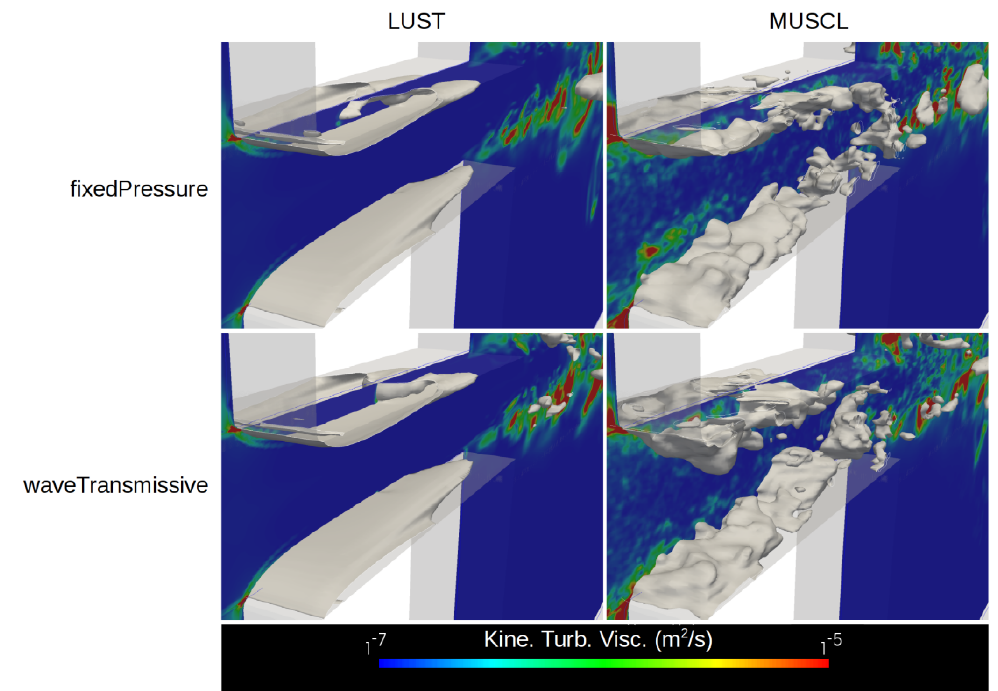
Figure 11. Colour distribution of the instantaneous turbulent viscosity throughout the centre of the nozzle for LUST and MUSCL injected at 8.5 MPa with 12 mm geometry with a superimposed contour showing vapour fraction of